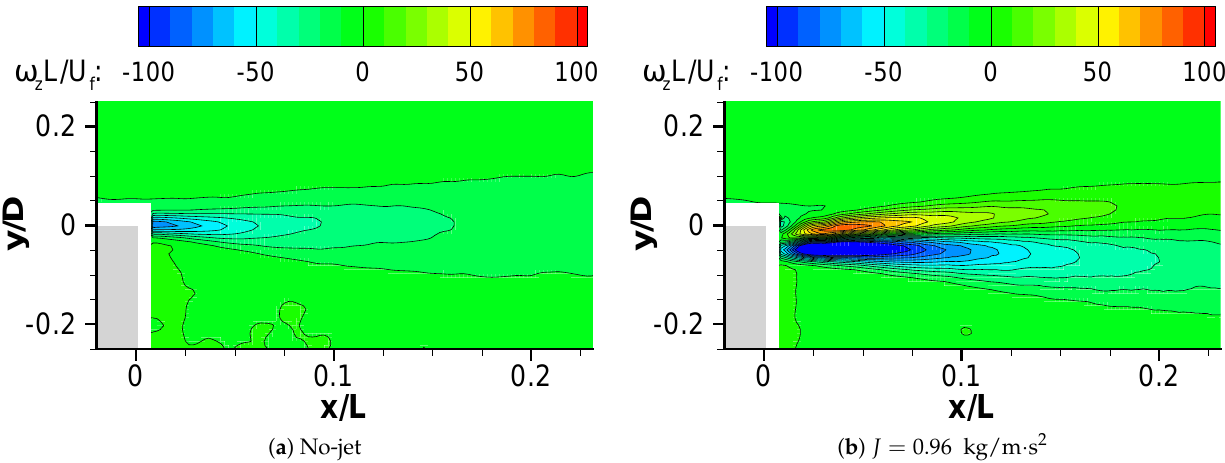
Figure 14. Contours of the time-averaged dimensionless time-averaged Reynolds shear stress < u (cid:48) v (cid:48) >/ U 2 sharp edge at LE; different J .